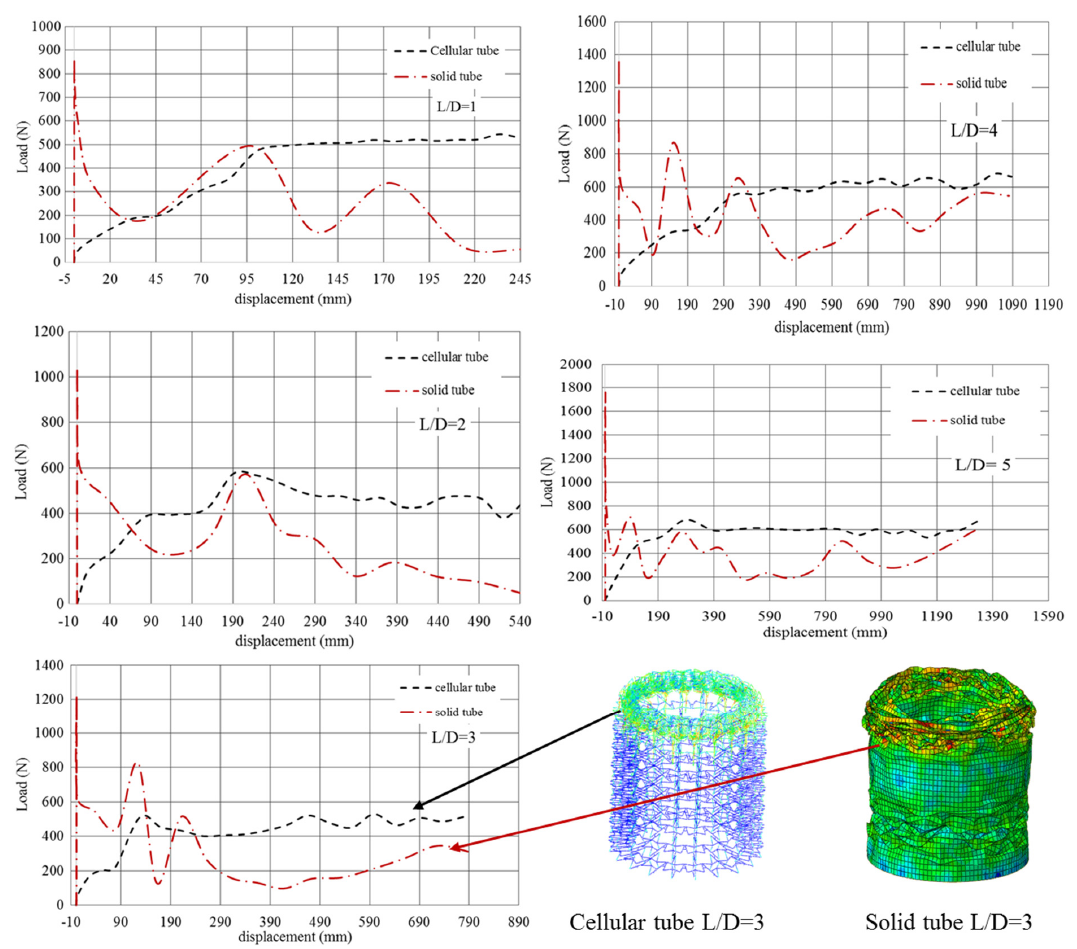
Figure 11. Load-displacement curve for solid and cellular tubes with different aspect ratios.